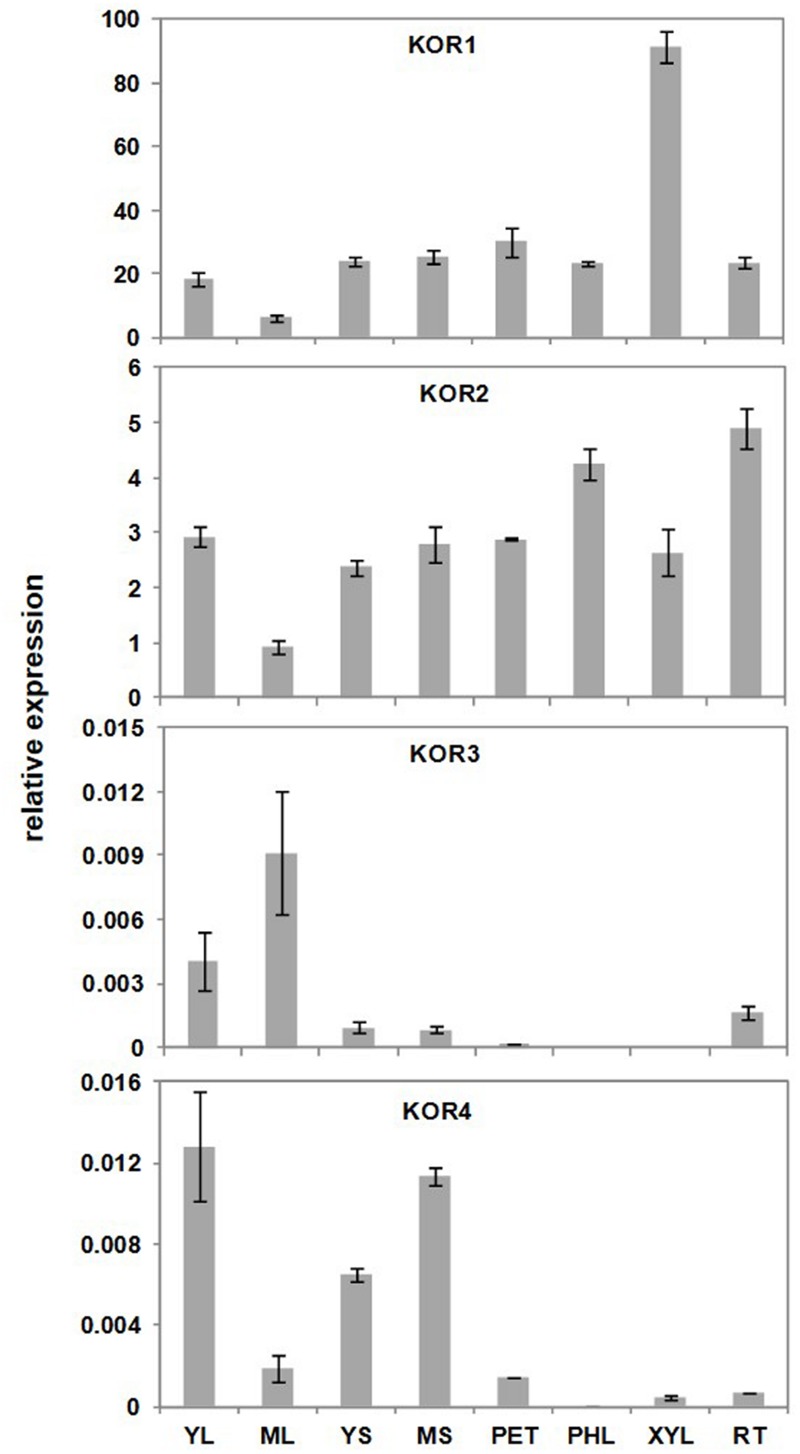
Relative expression of KOR-like genes in various Populus tissue types. Relative expression (arbitrary units) was based on difference in critical threshold (CT) values between target gene and average of housekeeping genes, Ubiquitin-conjugating enzyme E2 and 18S ribosomal RNA. Expression of PdKOR5 (KOR5) was below quantifiable limits. YL, young leaf; ML, mature leaf; YS, young stem; MS, mature stem; PET, petiole; PHL, phloem; XYL, xylem; RT, root. Data represent means ± SE (n = 3).